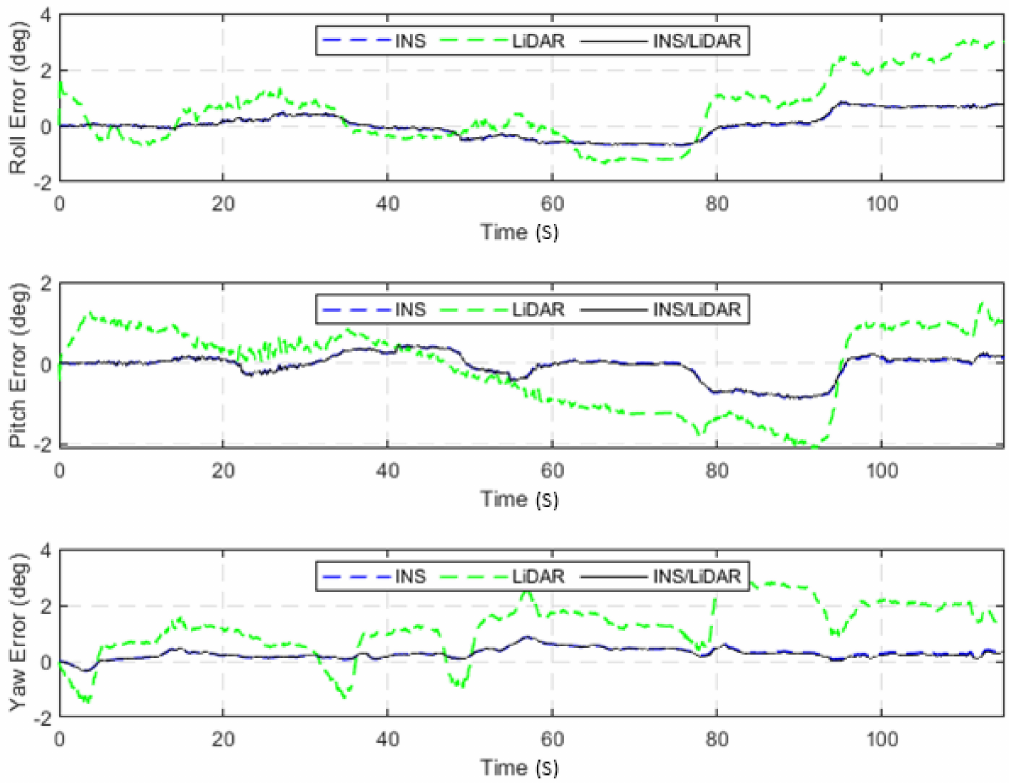
Figure 4. D-27—complete GNNS signal outage: errors of attitude angles (roll, pitch, and